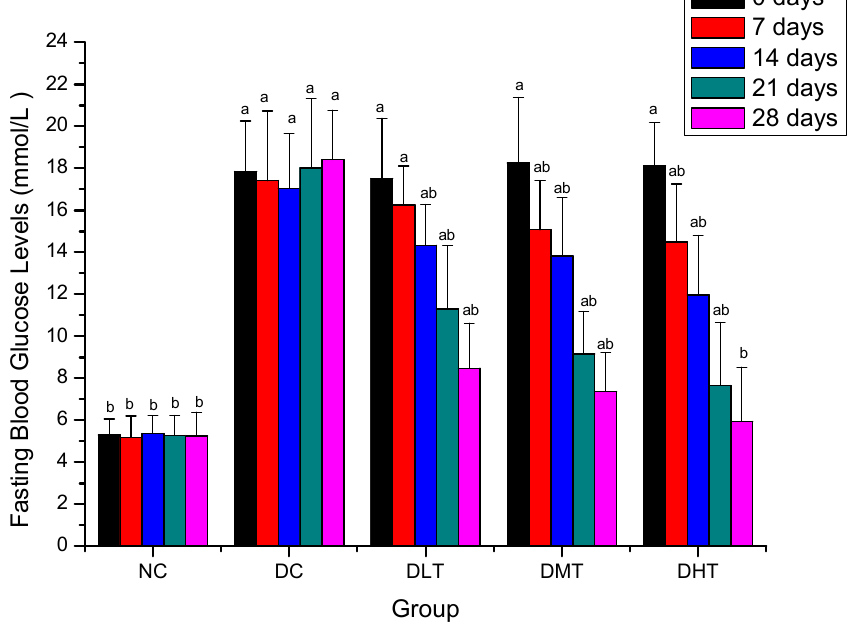
Figure 2. Effect of salidroside administration on fasting blood glucose levels in mice. Data were presented as means ± SD. NC: normal control, DC: diabetic control; DLT: low dose salidroside (50 mg/kg) treatment, DMT: middle dose salidroside (100 mg/kg) treatment, DHT: high dose salidroside (200 mg/kg) treatment. a P < 0.05 as compared with the NC group. b P < 0.05 as compared with the DC